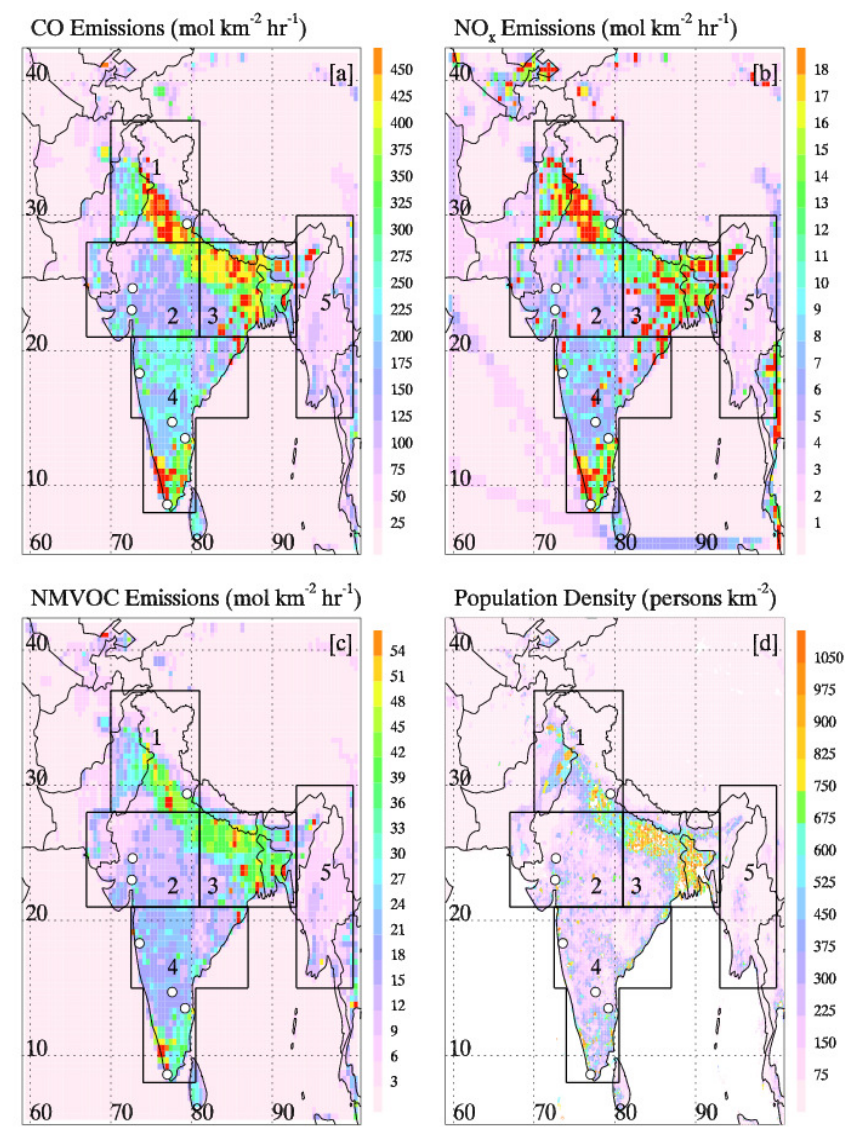
Fig. 1. Spatial distributions of total anthropogenic (a) CO, (b) NO x and (c) non-methane volatile organic compounds (NMVOC) emissions and (d) population density over the simulation domain. The emissions are representative of January. Regional classification of (1) North India, (2) West India, (3) East India, (4) South India and (5) Burma is also shown along with the locations of surface ozone observation sites (white filled circles) over the Indian region.